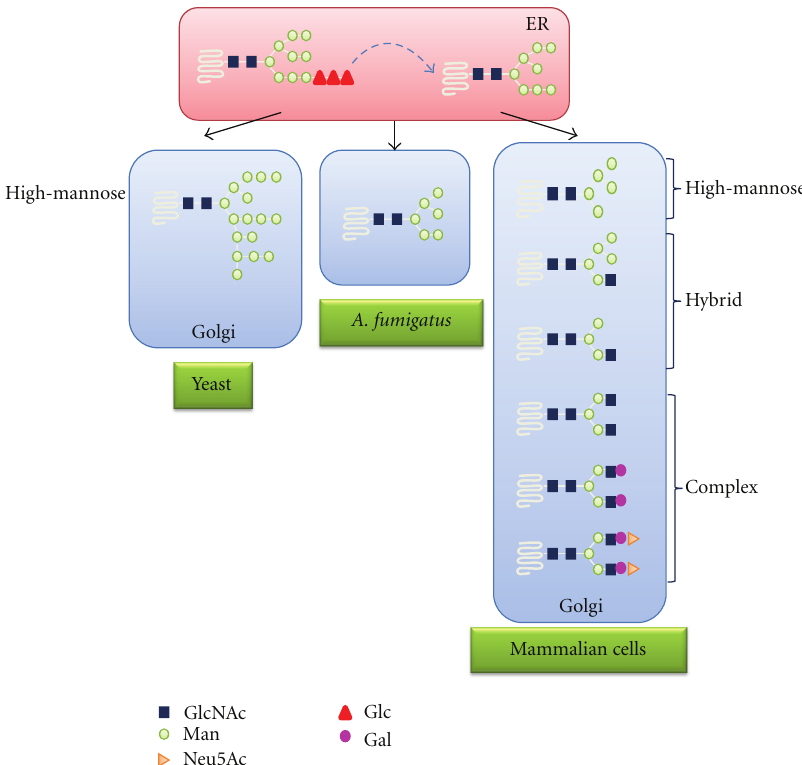
Figure 3: Comparison of N-glycans in yeast, A. fumigates, and mammalian cells. After processing by two ER α -glucosidases, the N-glycan is further processed by the action of various α 1,2-mannosidases. In S. cerevisiae , a specific ER α 1,2-mannosidase converts Man 9 GlcNAc 2 into Man 8 GlcNAc 2 , which is elongated in the Golgi to form an outer chain containing up to 200 residues of mannose. In A. fumigatus, the N-glycans on mature glycoprotein are Man 6 GlcNAc 2 . In mammalian cells, Man 9 GlcNAc 2 is converted to Man 5 GlcNAc 2 by the action of ER and Golgi α -mannosidases, which is the precursor for complex, hybrid, and high-mannose